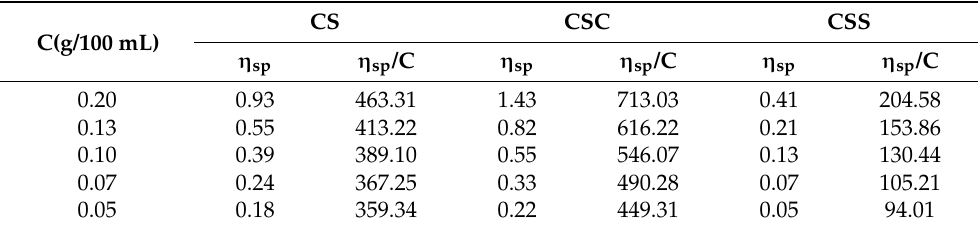
Table 2. Data of chitosan viscosity measurement.